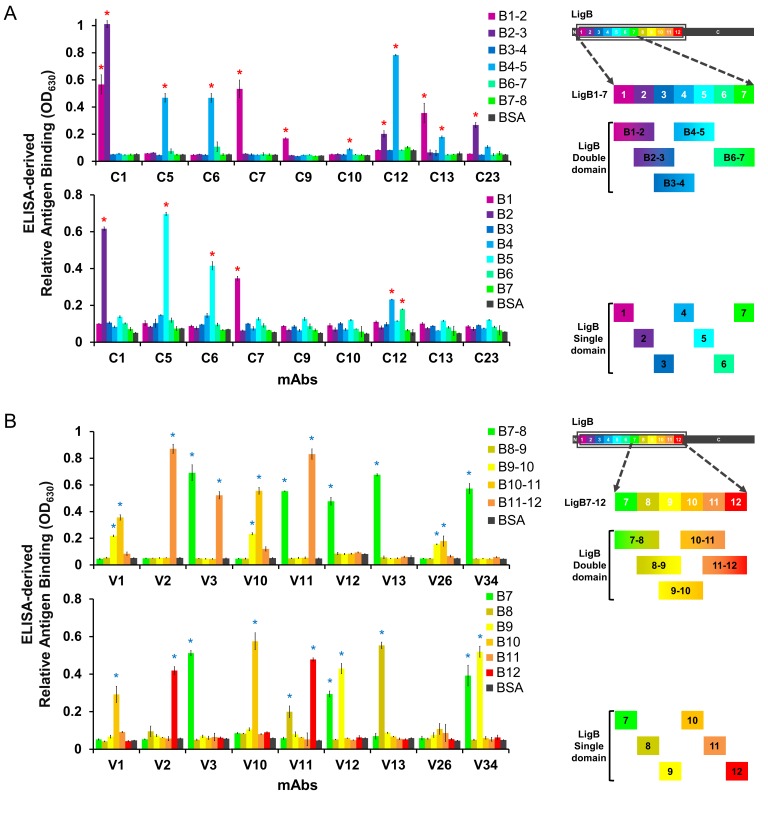
Domain-level epitope mapping of anti-LigB mAb library determined by ELISA.An array of double and single Ig-like domains from (A) LigB1-7 (1 μg/well) or (B) LigB7-12 (1 μg/well) and BSA (negative control) were coated on the microtiter plates for epitope mapping of mAbs. A fixed concentration (1 μM) of individual mAbs was applied to the LigB-coated wells. The binding levels of the mAbs were measured by rabbit anti-mouse IgG antibody conjugated with HRP (1:5000). Colors correspond to relative domain position. All experiments were conducted in three trials, the mean ±S.D. of which were shown in bar charts. Positive binding domains were identified by comparing with BSA and statistically significant (t-test; p<0.05) differences were marked by an asterisk and indicated in Table 1.